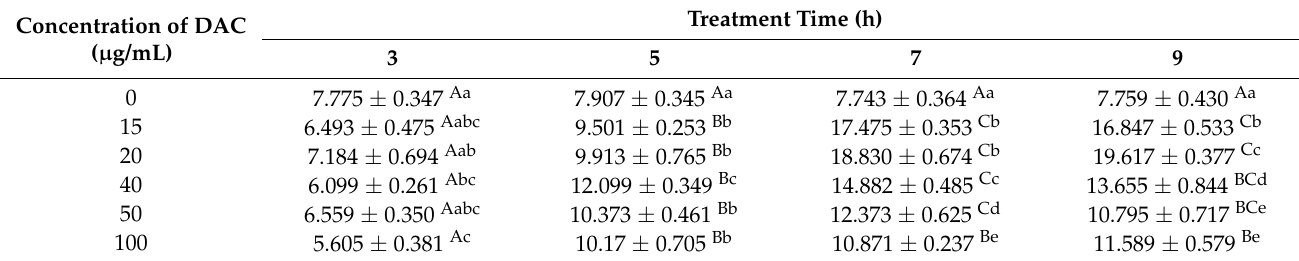
Table 13. The effect of DAC on SOD activity in GMEC (U/mL).